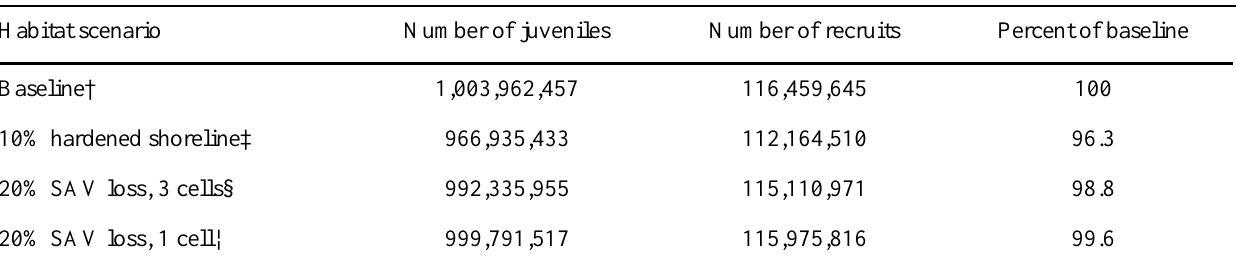
Table 1. Estimated numbers of juvenile blue crab by habitat type and the resulting numbers of recruits to the adult stock based on habitat scenarios and pre-recruit survival. Cell refers to units of the hexagonal spatial grid overlain on the Mobile Bay